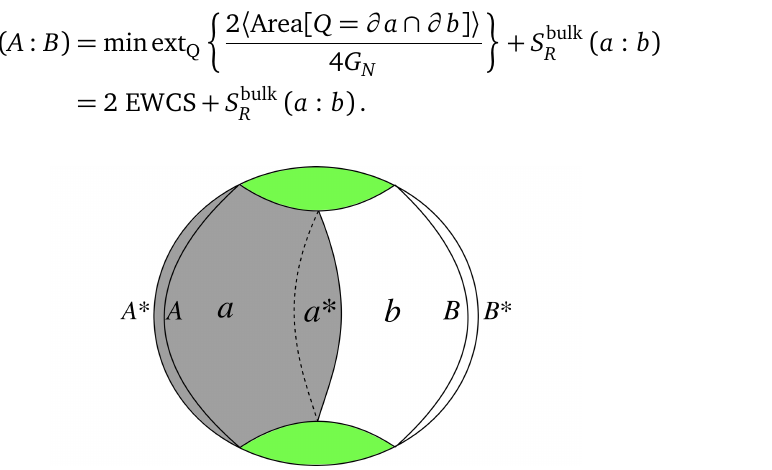
Figure 1: Schematic for the holographic construction of reflected entropy. Figure modified from [ 67,69